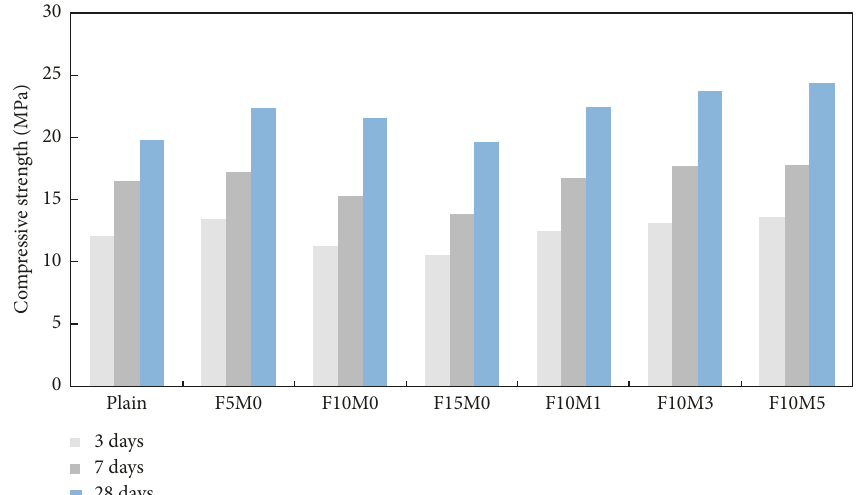
Figure 6: Compressive strength of the cement mortar with RMAP.